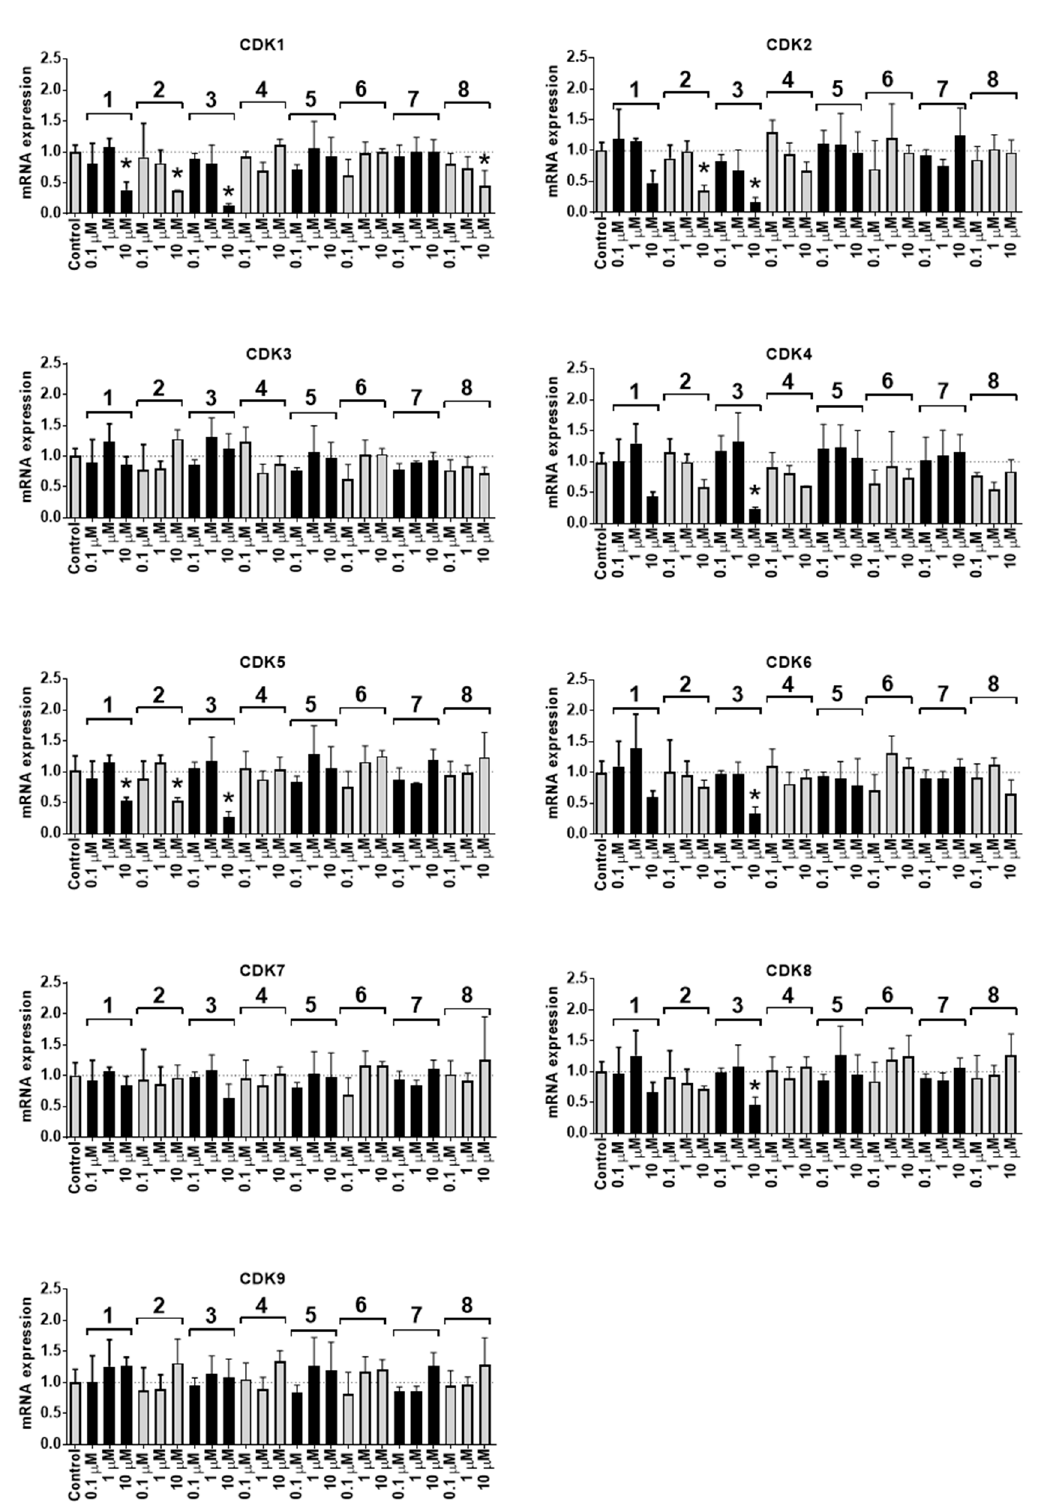
Figure 5. Expression of mRNA correspondent to CDK1-9 in PC-3 cells treated with the isolated compounds 1 – 8 for 24 h. The target gene expression was normalized to GAPDH gene expression. * p ≤ 0.05 (Student’s t-test).